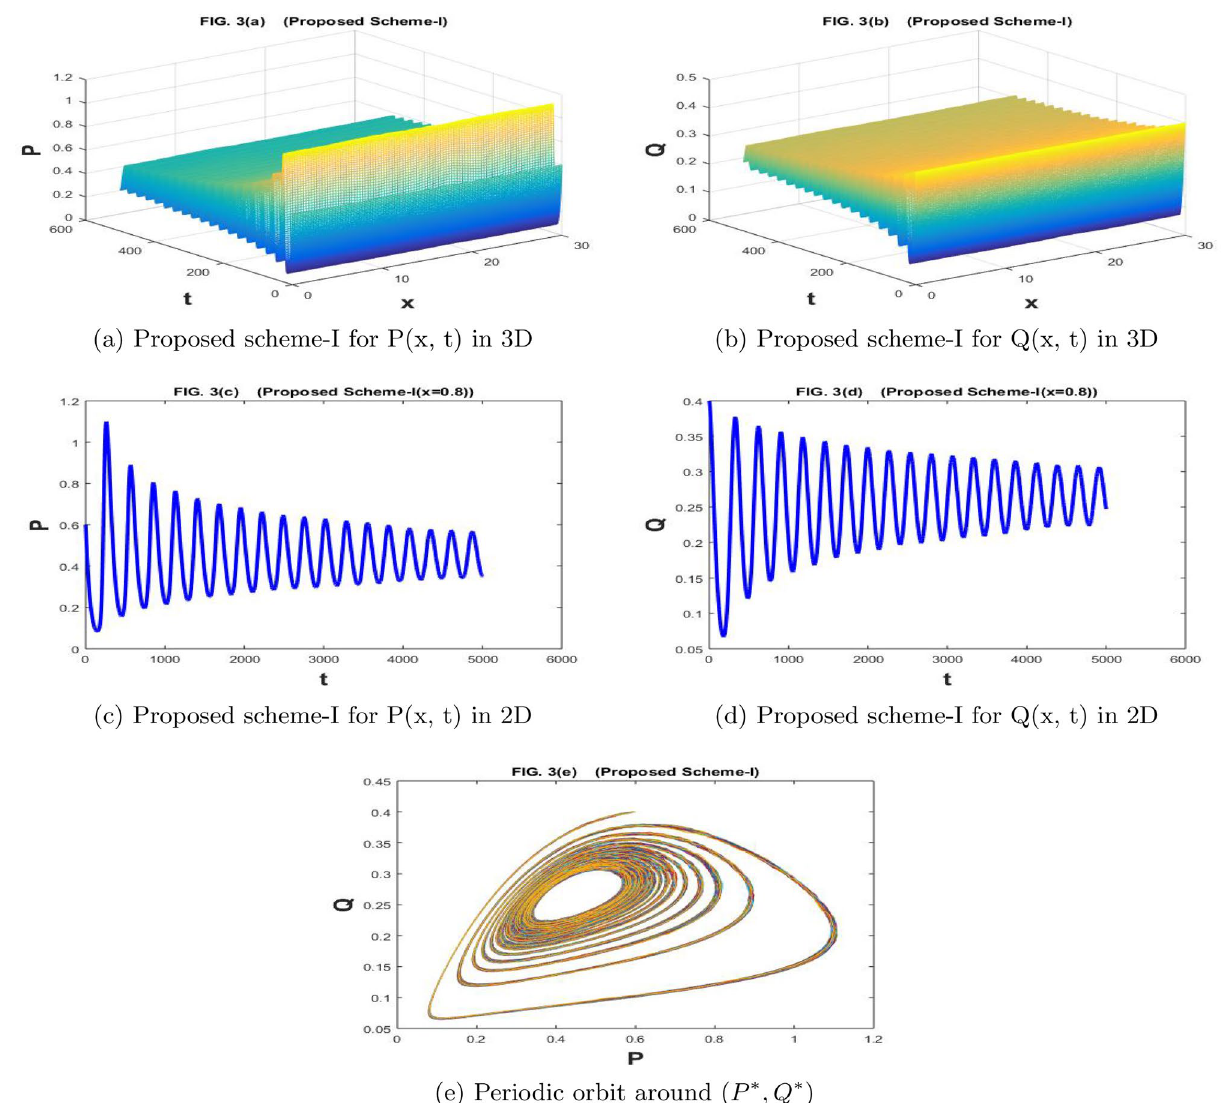
Figure 3. The subfig ( a and c ) and ( b and d ) represents the numerical approximation of P ( x , t ), and Q ( x , t ) respectively by proposed scheme-I. The subfig ( e ) represents the periodic orbit around ( P ∗ , Q ∗ )